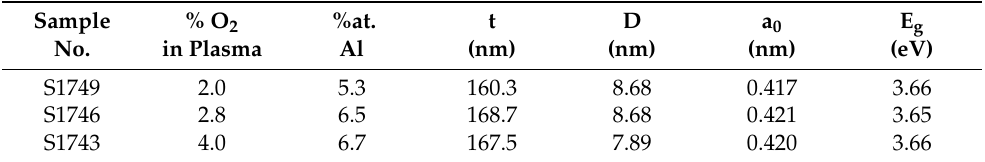
Figure 2. X-ray Diffraction (XRD) patterns of rf-sputtered NiO:Al films grown at room temperature with different O 2 content in plasma that underwent thermal annealing at 400 °C for 24 h. Table 1. Deposition parameters, thickness (t), crystallite size (D), lattice constant (a 0 ), and optical energy bandgap (E g ) of rf-sputtered Al-doped NiO